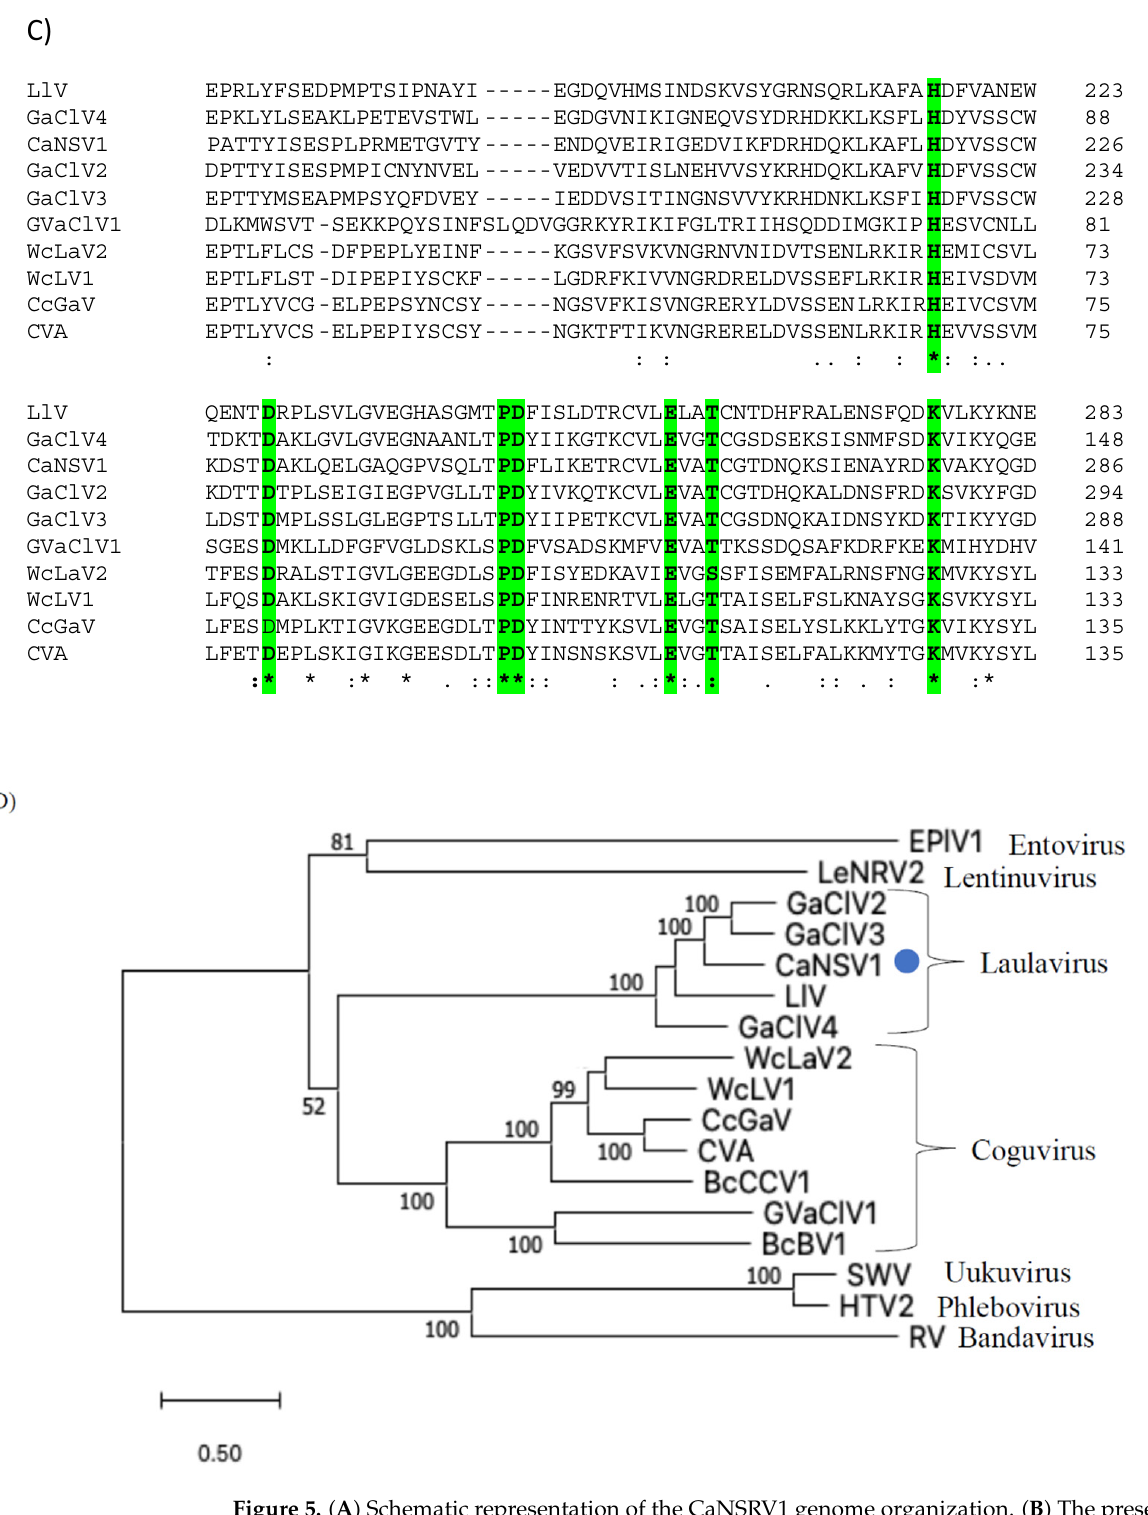
Figure 5. ( A ) Schematic representation of the CaNSRV1 genome organization. ( B ) The presence of the six conserved motifs, which included pre-motif A and motifs A–E, was verified by aa alignments in RdRps of CaNSRV1 and other related (-ss) RNA viruses, which match to highly conserved sections of the order Bunyavirales RdRps [34,47–49]. CaNSRV1 comprises the motifs A (DATKWC), B (QGILHYTSS), C (SDD), D (KS) and E (E(F/Y)xS). E is a tetrapeptide motif found in the RdRp of segmented negative-sense RNA viruses. Furthermore, three basic residues in pre-motif A: K, R and R/K, as well as a glutamic acid. The conserved motifs are indicated by the colored boxes. (E) down- stream of pre-motif A, were shown to be conserved in CaNSRV1 and related viruses RdRps. ( C ) N- terminal region of CaNSRV1 had an endonuclease conserved motif that was engaged in cap-snatch- ing, a method adopted by many negative-stranded viruses to translate viral proteins by utilizing capped terminal ends of host mRNAs. The ExT domain conserved in the RdRp of most bunya- viruses is also found in CaNSRV1. ( D ) Alignment and phylogenetic reconstructions of RdRps of CaNSRV-1 and selected viruses were performed using the function “build” of ETE3 3.1.2 [39] as implemented on the GenomeNet (https://www.genome.jp/tools/ete/, accessed on 2 September 2022). Alignment was performed with MAFFT v6.861b with the default options [40]. ML tree was inferred using IQ-TREE 1.5.5 ran with ModelFinder and tree reconstruction [41], where best-fit model according to BIC was LG+F+R5. Tree branches were tested by SH-like aLRT with 1000